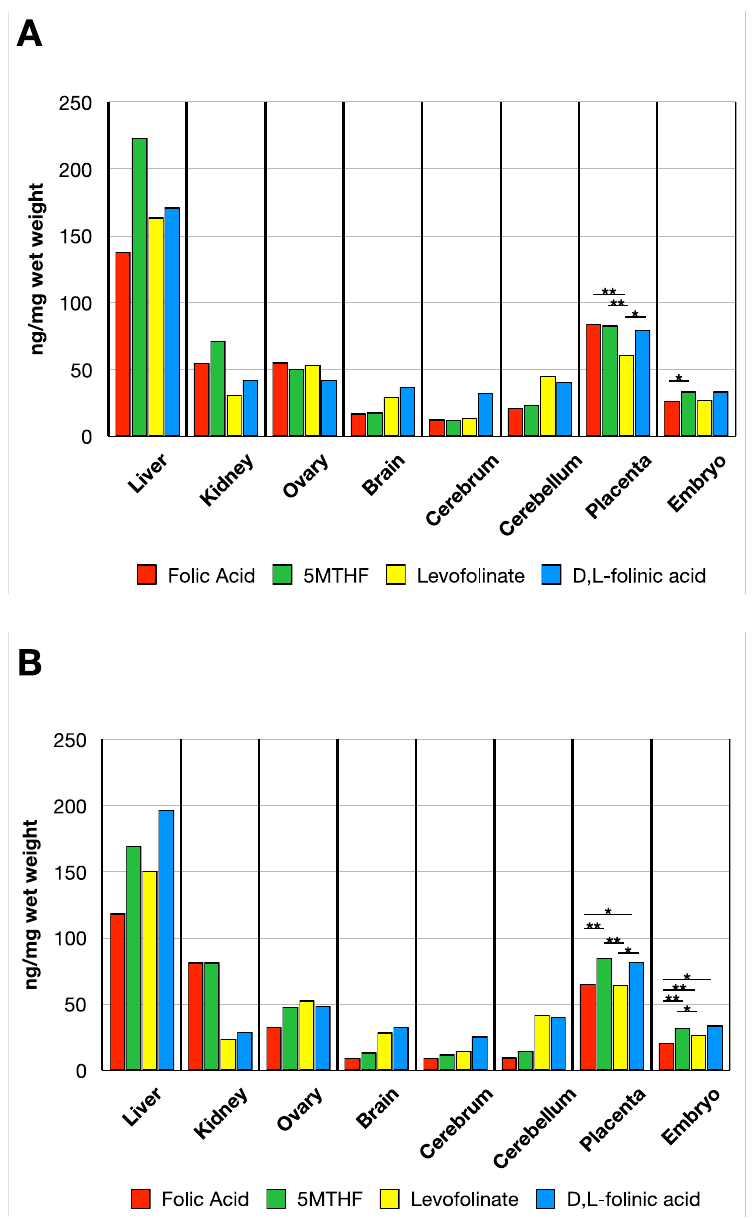
Figure 5. Methylfolate levels in a GD 14 pregnant rat following oral administration of folate forms, and IP administration with normal rabbit IgG (NR-IgG; ( A )) and rabbit anti rat FR α antibody (FR α Ab; ( B )) Asterisks indicate the following: * p < 0.05, ** p < 0.01.